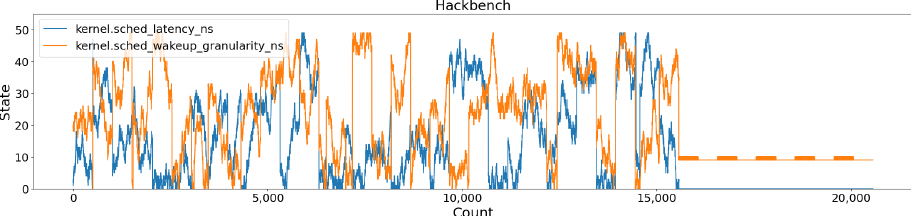
Figure 7. State changes in two parameters during STUN learning The x-axis is the number of runs, and the y-axis is the state of each